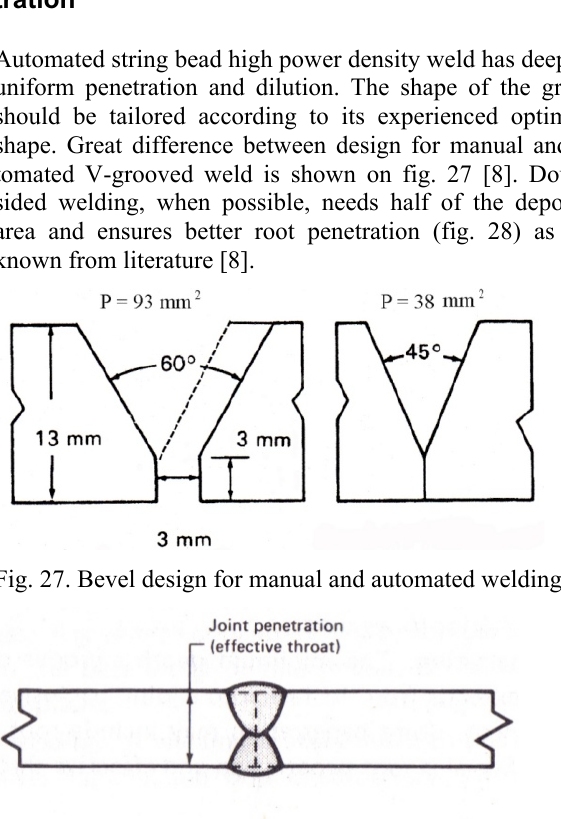
Fig. 28. Double-sided